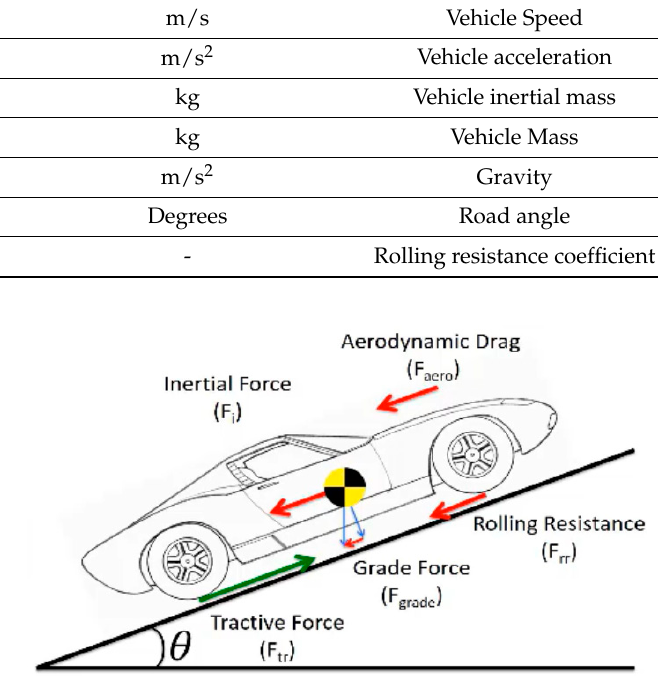
Figure 5. Vehicle body glider model Adapted from [16], MathWorks: 2020.